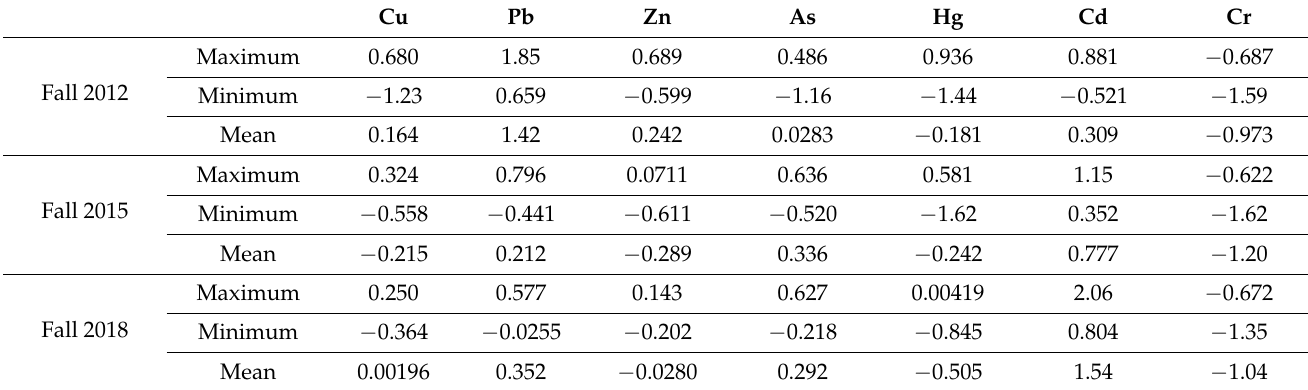
Table 3. Statistical Results of the Geoaccumulation